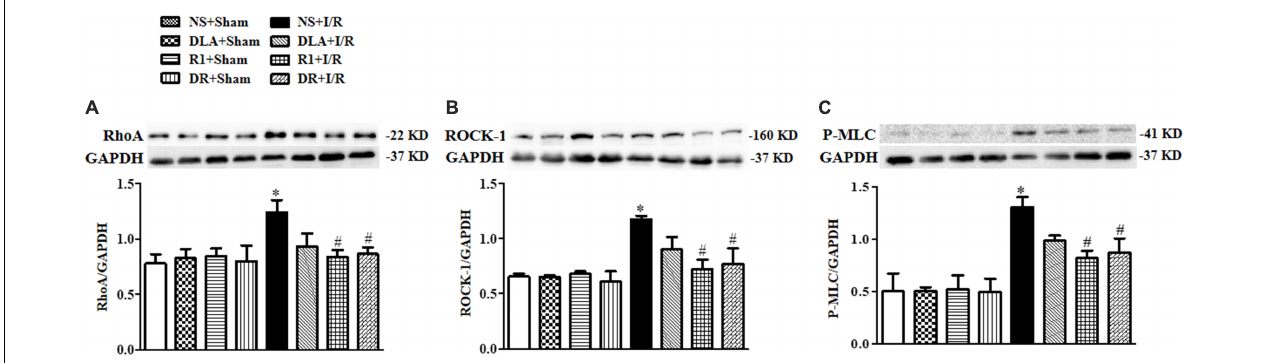
FIGURE 10 | The effect of DLA, R1, and DR pretreatment on the level of Ras homolog gene family, member A (RhoA), Rho-associated kinase (ROCK), and phosphorylated myosin light chain (P-MLC) in rat heart tissue after I/R for 90 min. (A) Examples of Western blot bands of RhoA in various groups with quantification shown below. Quantitative results for RhoA band intensities were normalized to GAPDH (n = 6). (B) Examples of Western blot bands of ROCK-1 in various groups with quantification shown below. Quantitative results for ROCK-1 band intensities were normalized to GAPDH (n = 6). (C) Examples of Western blot bands of P-MLC in various groups with quantitative results shown below. Quantitative results for P-MLC band intensities were normalized to GAPDH. Data are presented as means ± SEM (n = 6). * p < 0.05 vs. NS + Sham group; # p < 0.05 vs. NS + I/R group.